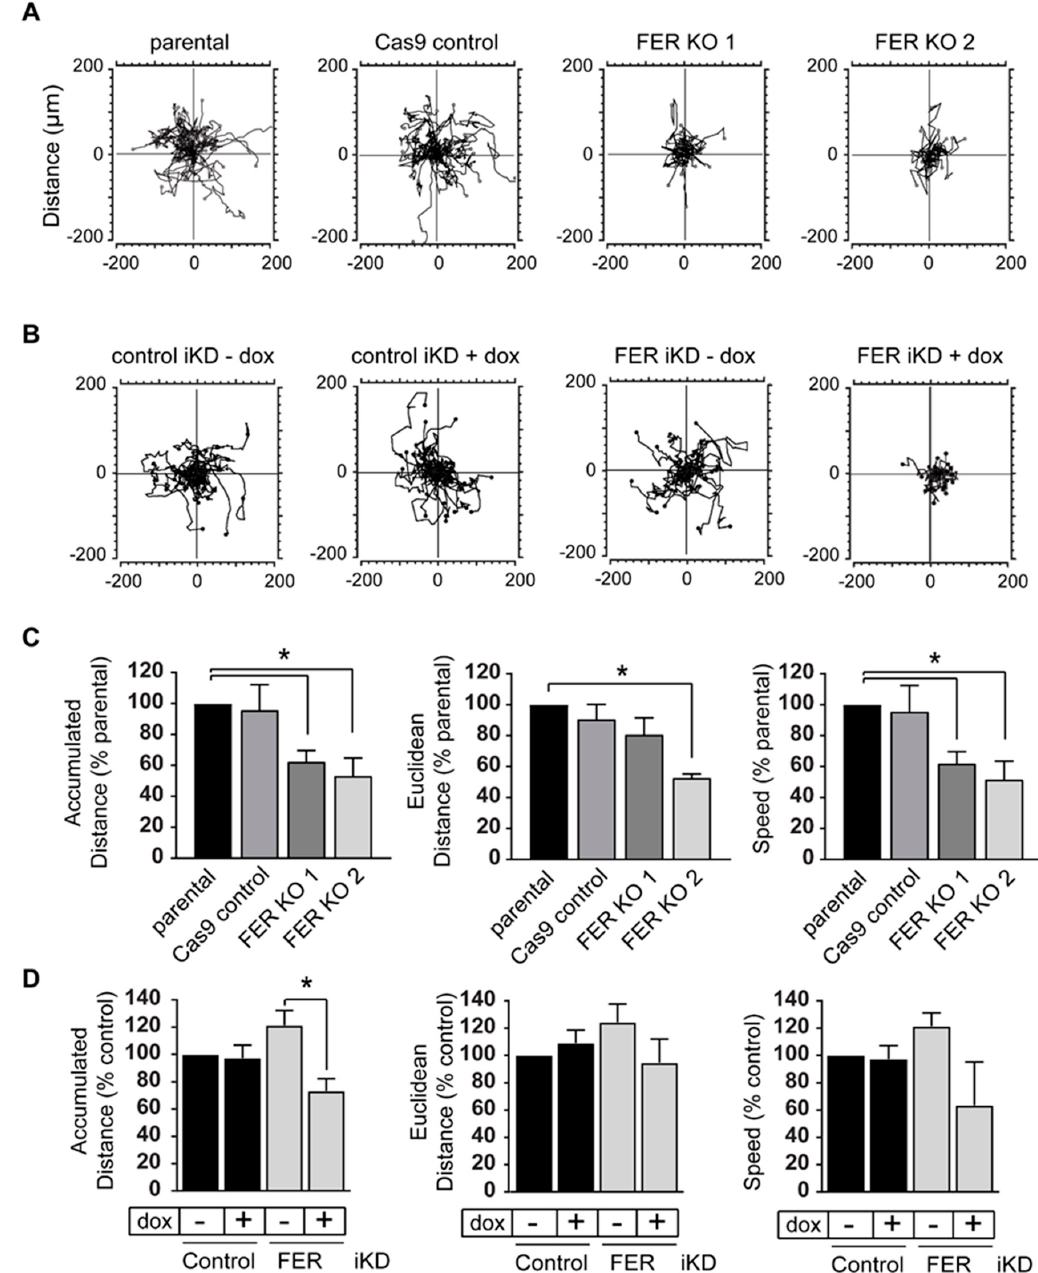
Figure 2. FER regulates melanoma cell motility. ( A ) A375 ‐ MA2 parental, Cas9 control and FER KO cells were cultured in medium containing 0.5% FBS for 96 h or ( B ) Control and FER iKD 131/4 ‐ 5B1 cells were cultured in medium with or without 2 μ g/mL of dox for 120 h. Then, cells were cultured on μ‐ Dishes coated with laminin 332. Cells were imaged for 16 h using time ‐ lapse videomicroscopy and analyzed using Image J (NIH) and the Chemotaxis and Migration Tool Software (ibidi). ( A , B ) Representative migratory paths of FER ‐ expressing and FER ‐ deficient cells on laminin 332. The initial migratory point of a cell is represented as (0,0) and the final point is illustrated as a closed circle. ( C , D ) At least 100 cells were tracked per cell line or condition per experiment. Histograms represent mean ± SEM ( N = 3) accumulated (total) distance, Euclidean distance (straight linear distance from the initial to final migratory point) and speed of cells normalized to those of parental cells ( C ) or control – dox cells ( D ). * represents p < 0.05 (One ‐ way ANOVA, Tukey’s post hoc test).